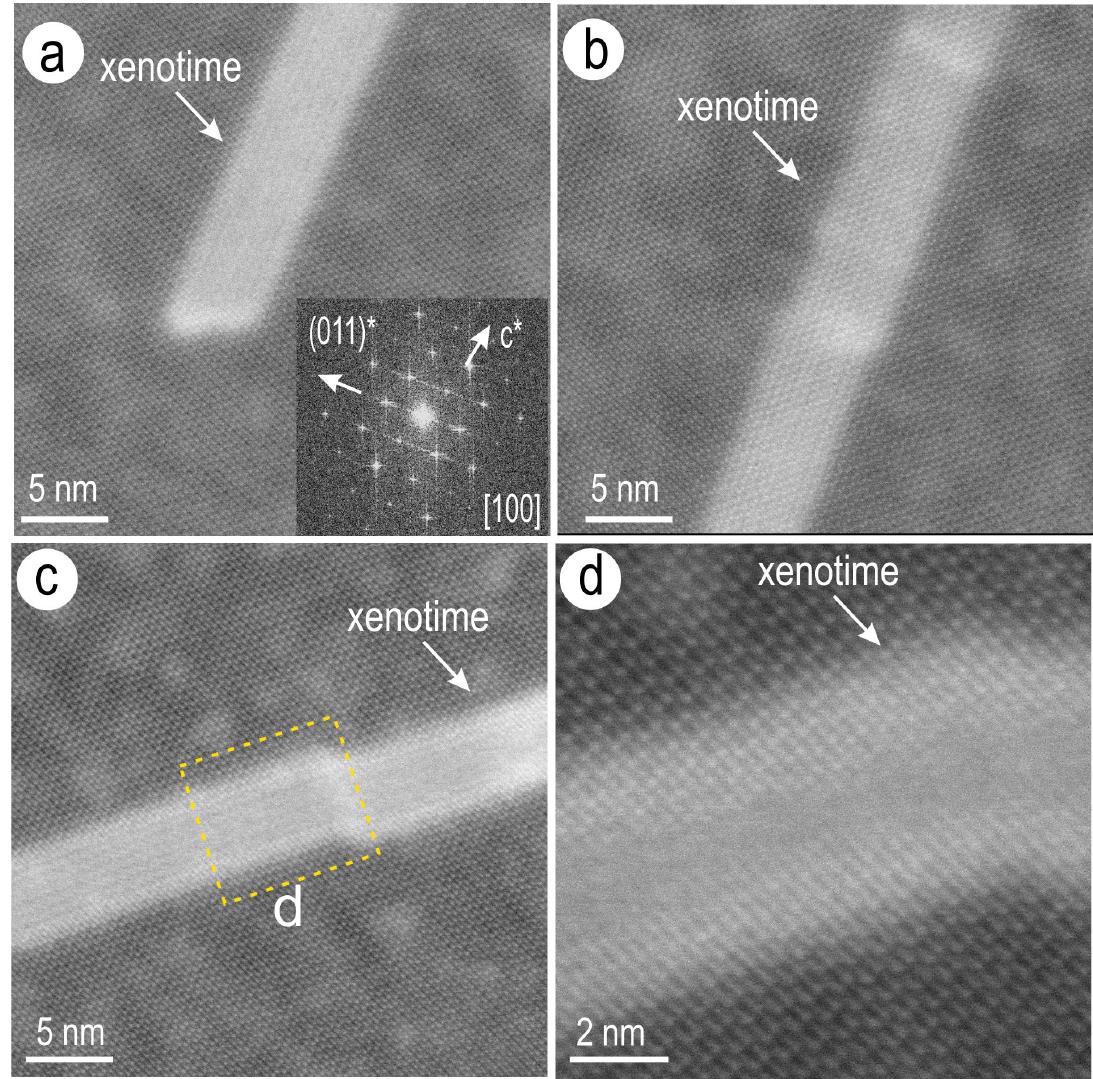
Figure 15. High-resolution HAADF STEM images on [100] Sch/Pow showing lamellae of xenotime in scheelite-powellite (Sch-Pow) zoned grain of intermediate composition (foil #1). ( a ) Sharp edge of lamella epitaxially intergrown with Sch-Pow as shown on FFT from inset. ( b , c ) Images showing the xenotime lamellae are homogenous and display kink-steps. ( d ) Detail of xenotime lamella (rectangle marked in c) showing the edges are embedded within the host Sch-Pow.